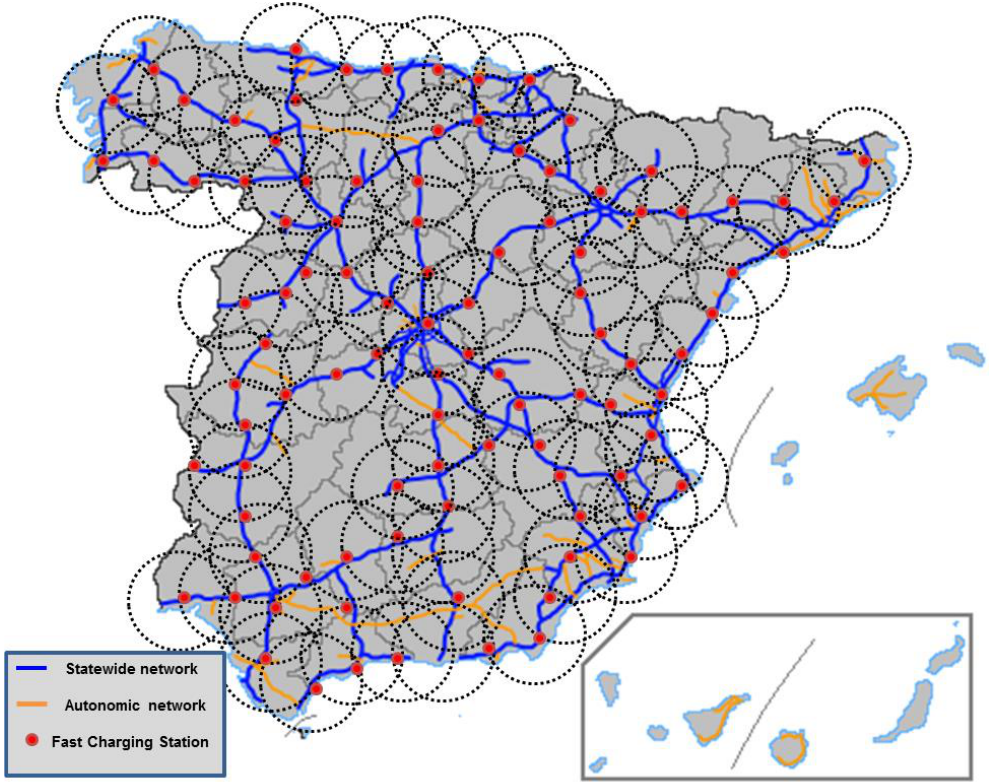
Figure 10. State highway network and MDFC range, individual range model.